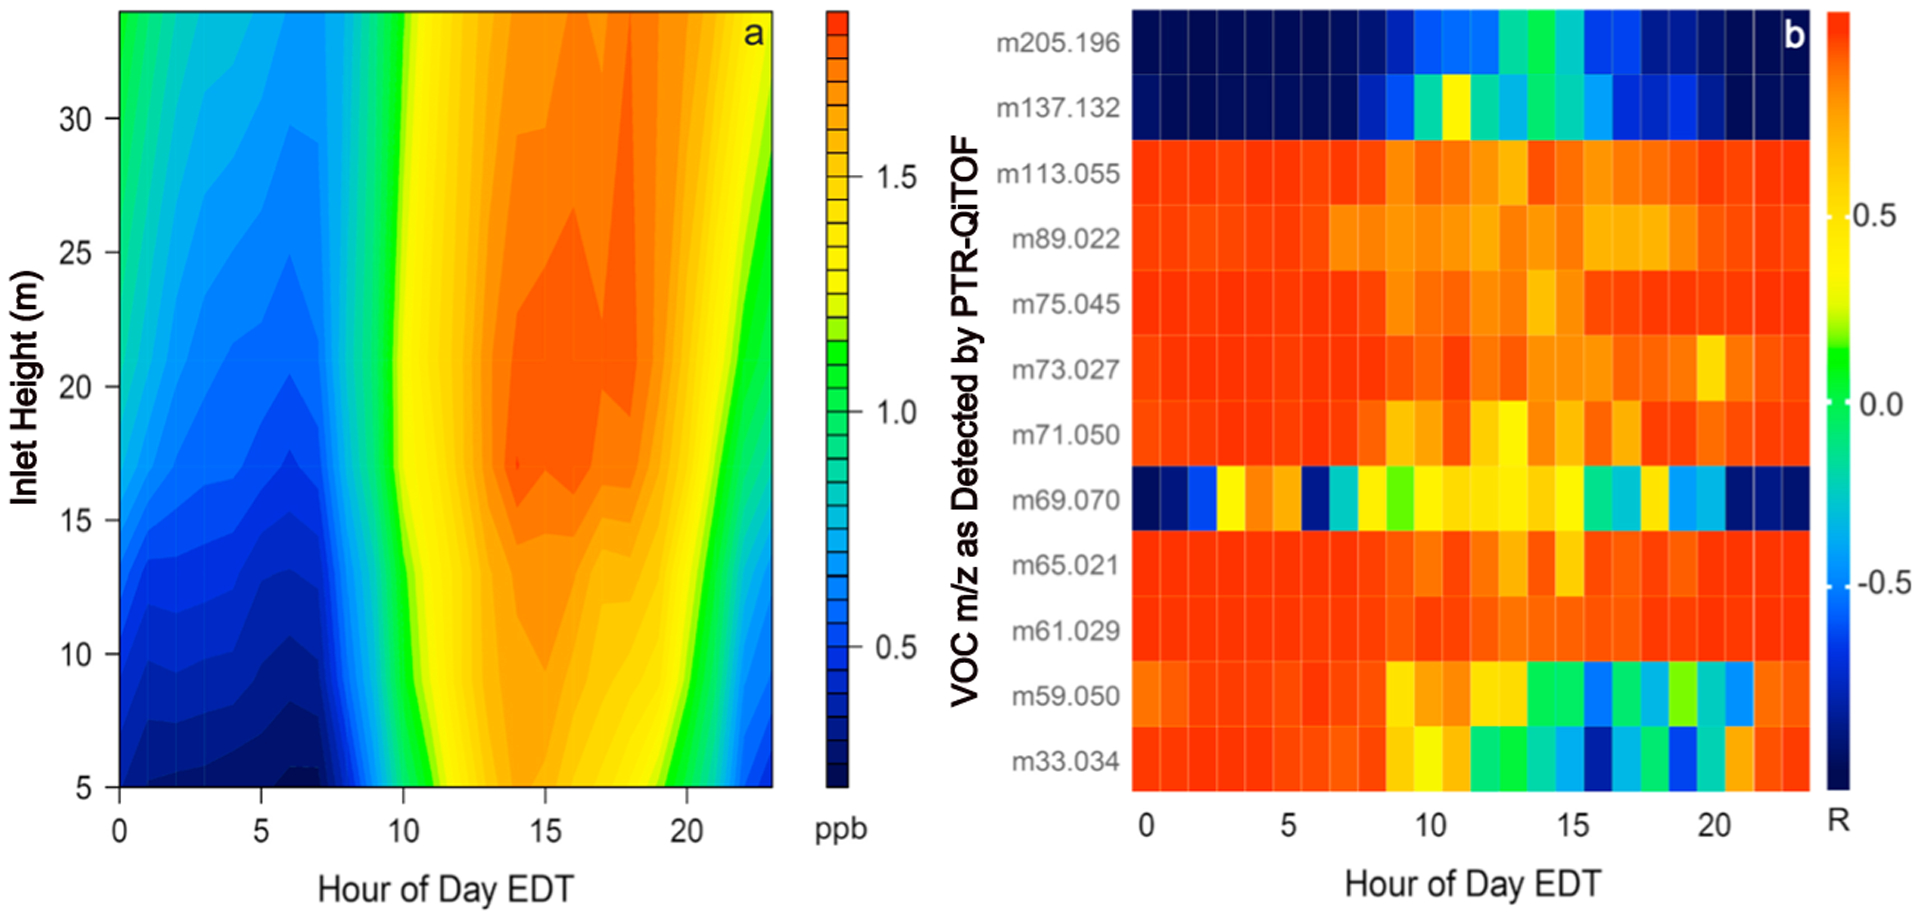
In-canopy vertical gradients of HCOOH and correlations with tracers of known origin. (a) Curtain plot showing the mean diel cycle of HCOOH vertical gradients for the PROPHET-AMOS campaign. (b) Mean hourly correlations between the HCOOH vertical gradients and those for selected other VOCs: m/z 33.034 = methanol; m/z 59.050 = acetone; m/z 61.029 = acetic acid/glycolaldehyde; m/z 65.021 = CH5O3+; m/z 69.070 = isoprene; m/z 71.050 = MVK + MACR; m/z 73.027 = methylglyoxal; m/z 75.045 = hydroxyacetone; m/z 89.022 = C3H5O3+; m/z 113.055 = C6H9O2+; m/z 137.132 = monoterpenes; m/z 205.196 = sesquiterpenes.